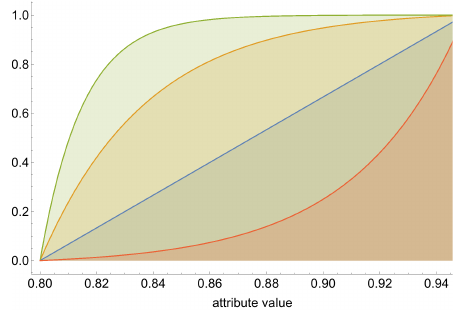
Figure 9. Risk aversion example, r = f 0 ; 4 ; 10 ; (cid:0) 4